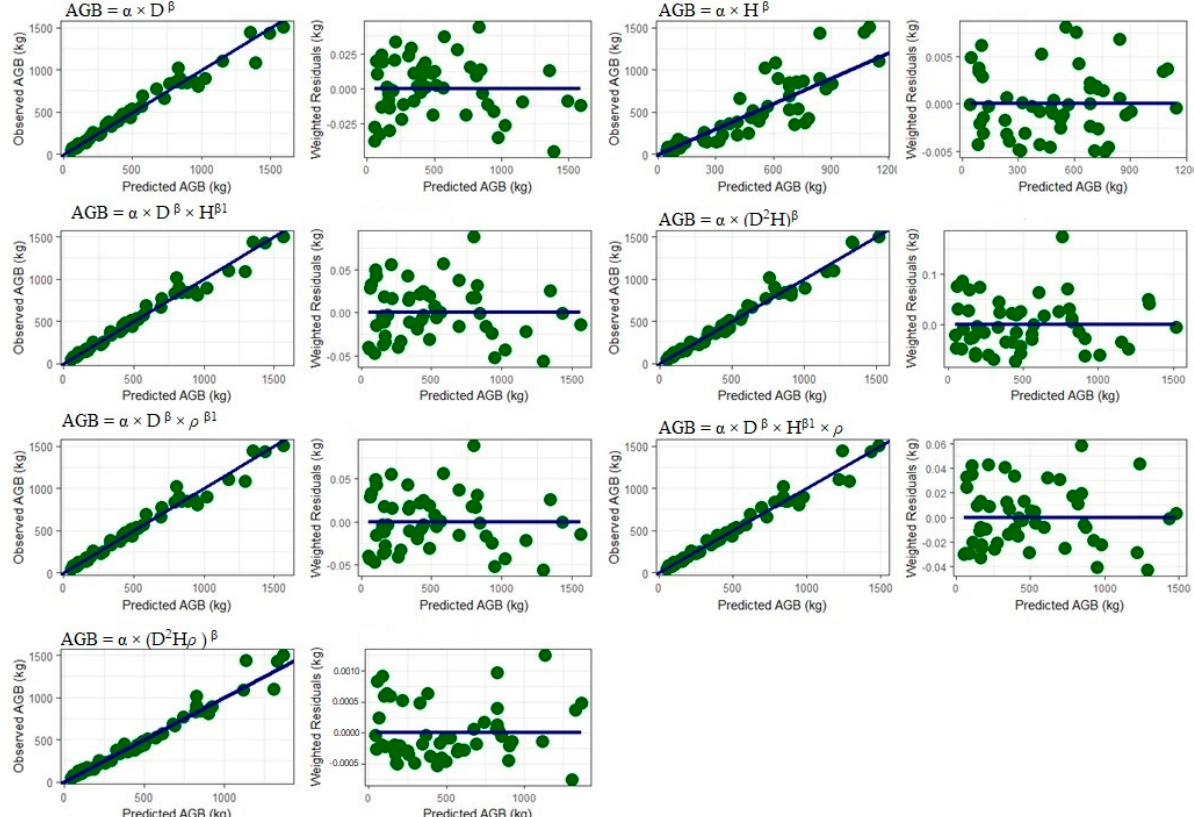
Figure 3. Relationship between aboveground biomass (AGB, kg tree − 1 ) and predictor variables, D (cm), H (m) and ρ (kg m − 3 ) and weighted residuals, for the candidate Equations (3) to (9) based on data for 52 sample trees. See Table 4 for criteria associated with these regressions.